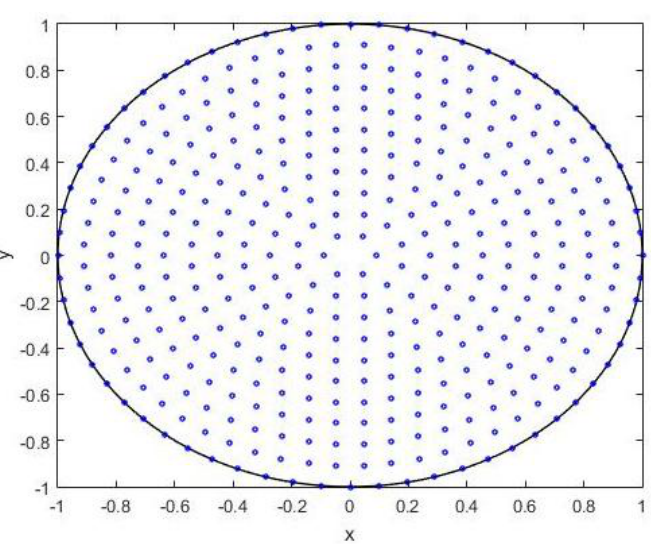
Figure 1. The computational and evaluational domain of a unit disk with 394 uniformly scattered data